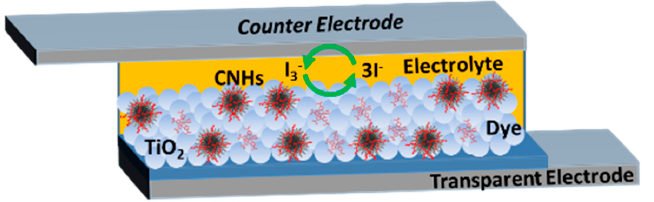
Figure 10. Configuration of a dye-sensitized solar cell (DSSC) using CNHs as additive.